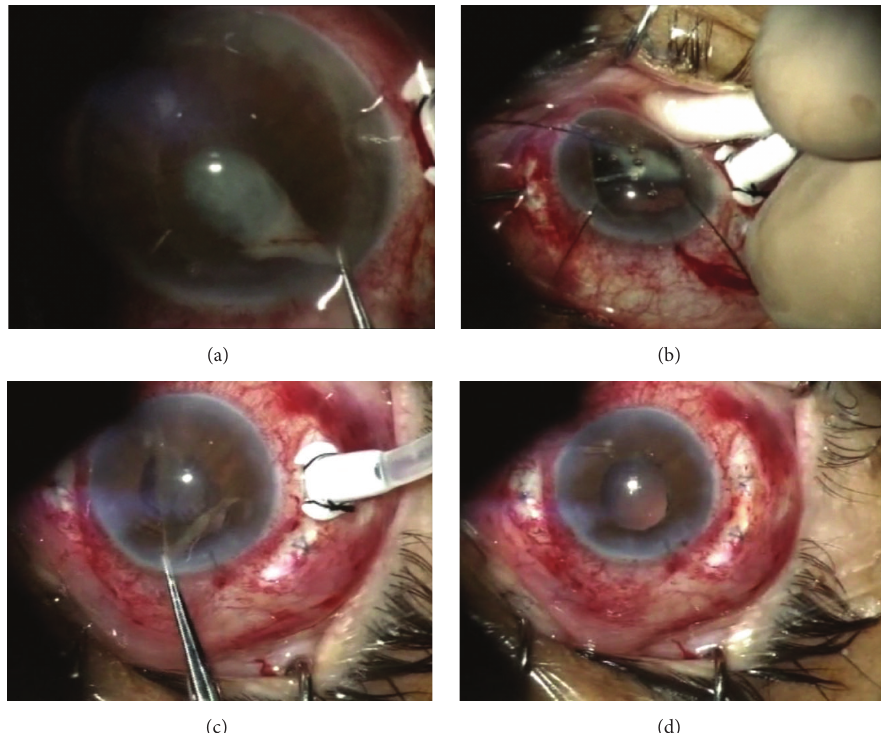
Figure 2: Removal of pupillary membrane (a). Shaving of vitreous base (b). Removal of iris membrane remnants (c). Concluded surgery (d).